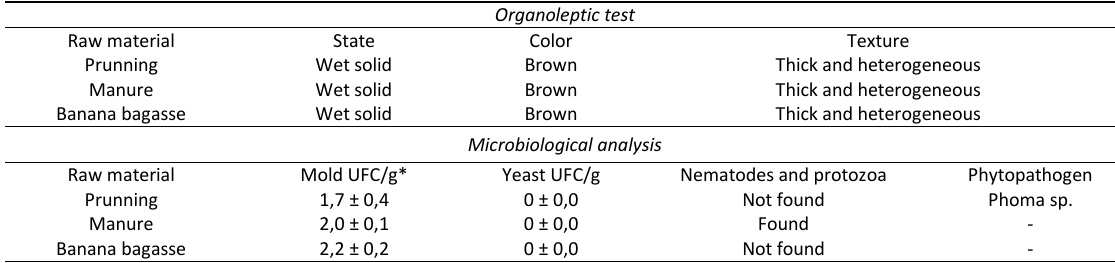
Table 1: Quality parameters for raw